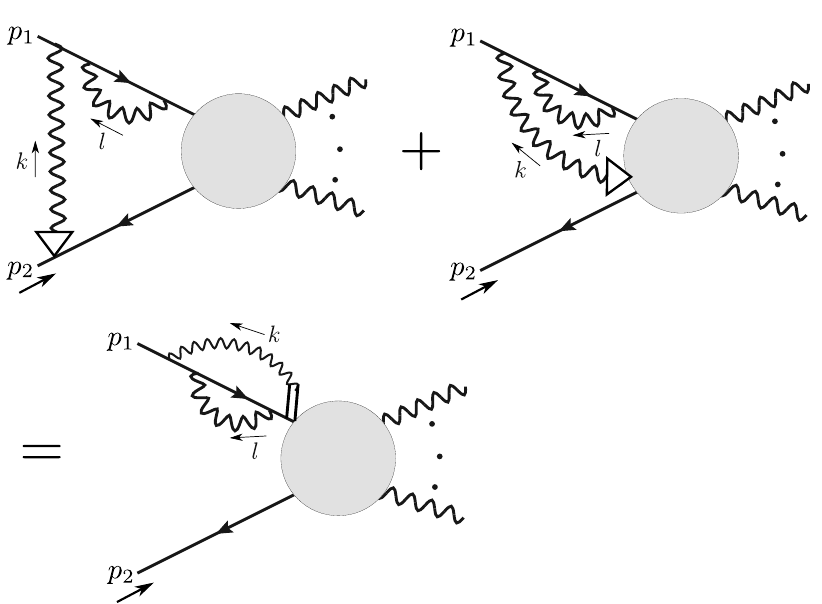
Figure 13. Illustration of the desired factorization property of type S diagrams in the collinear k k p 1 limit. Prior to integration, the propagator denominator ( p 1 + k ) 2 appears twice, giving rise to power divergences in the collinear limit. Appropriate modifications of the diagrams are needed to reduce the divergence to a logarithmic one, so that we can apply the collinear approximations, in particular the polarization approximations eq. (3.18) with q = k indicated by the triangle arrow.